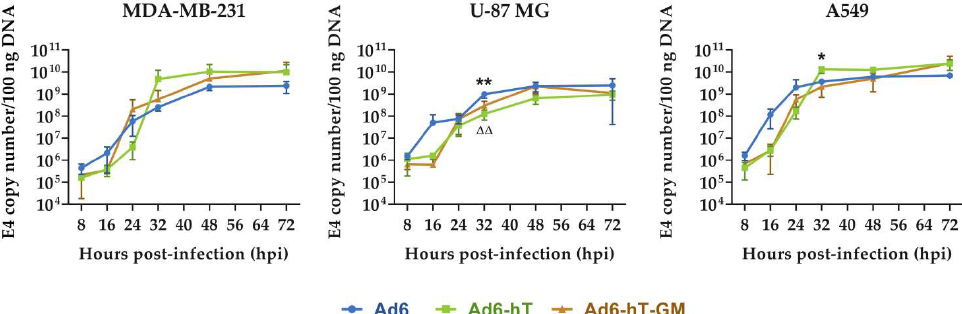
Figure 2. The influence of genome modifications on the rate of adenoviral replication in various cell lines. MDA-MB-231, U-87 MG, and A549 were infected with Ad6, Ad6-hT, and Ad6-hT-GM with MOI = 100 vp/cell, and DNA copy numbers were assessed at various time points by qPCR with primers for adenoviral E4 region. Data are presented as mean ± SD ( n = 3). The differences between viral copy numbers were analyzed by ANOVA followed by Tukey’s HSD post-hoc test for pairwise comparisons. * p < 0.05 and ** p < 0.01 denote significant differences between Ad6-hT and Ad6. ΔΔ p < 0.01 denotes significant difference between Ad6-hT-GM and Ad6.